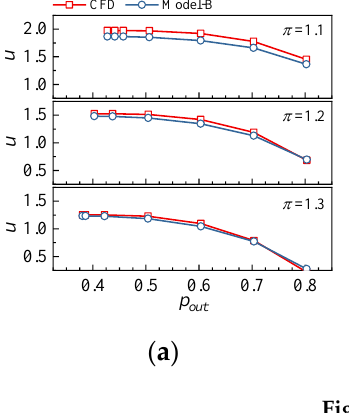
Figure 3. The validation of injection characteristics of the basic VABI model: ( a ) A VABI = 0.8; ( b ) A VABI = 0.6; ( c ) A VABI = 0.4.